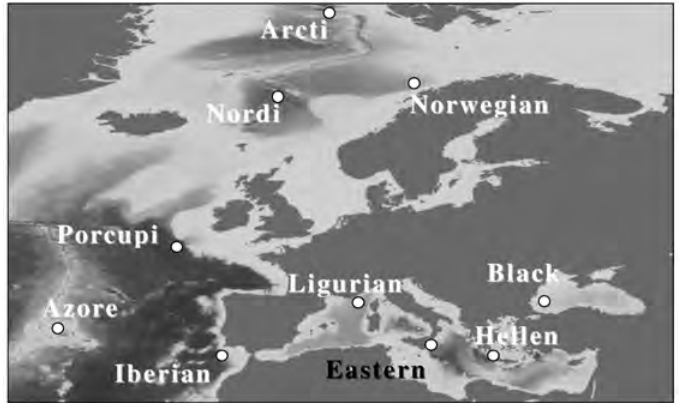
Fig. 12. Map of the «key-sites» of the European ocean margins proposed by ESONET (Priede et al. , 2003,